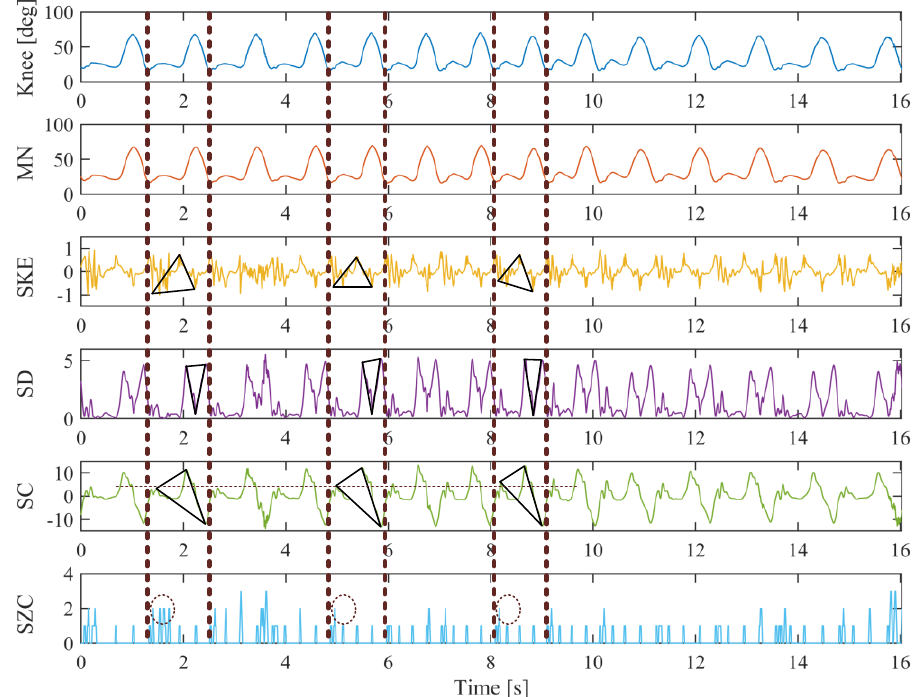
Figure 7. Feature extraction example of the “acceleration- > fast walking- > deceleration” walking of subject 1.